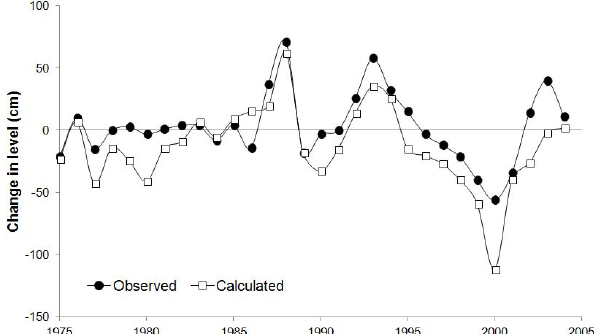
Fig. 2. Monthly lake water level time series.